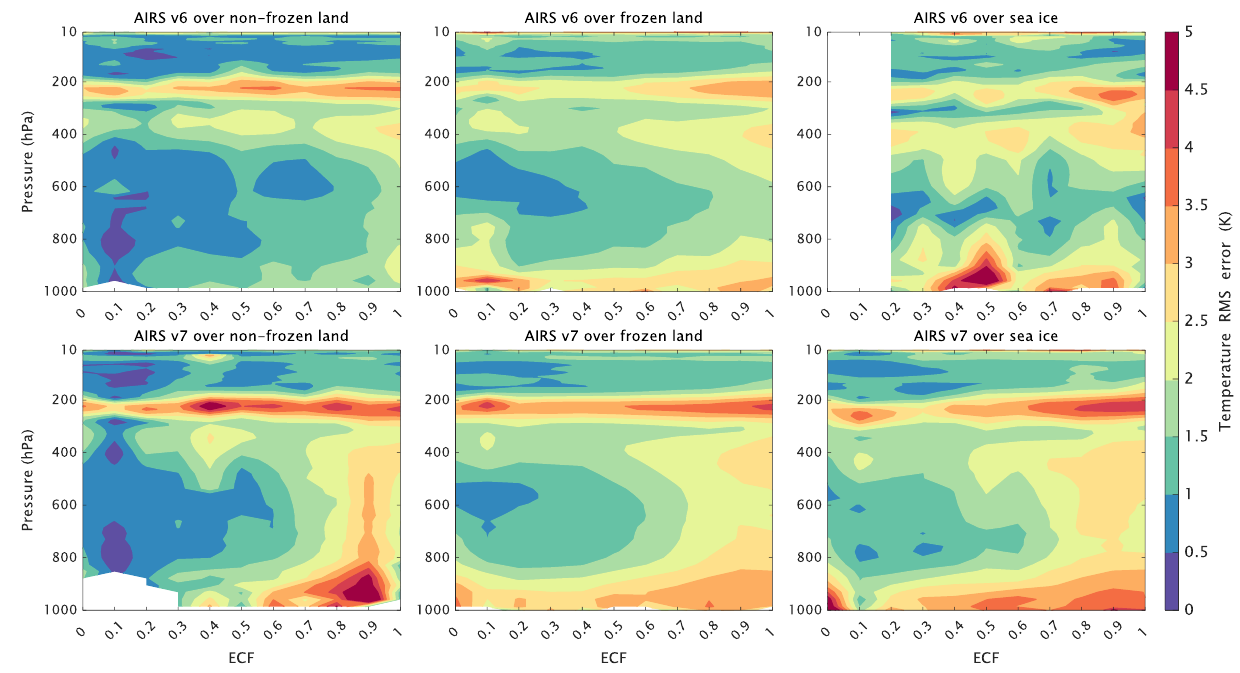
Figure 10. Similar to Figure 9 but showing the RMS error results.